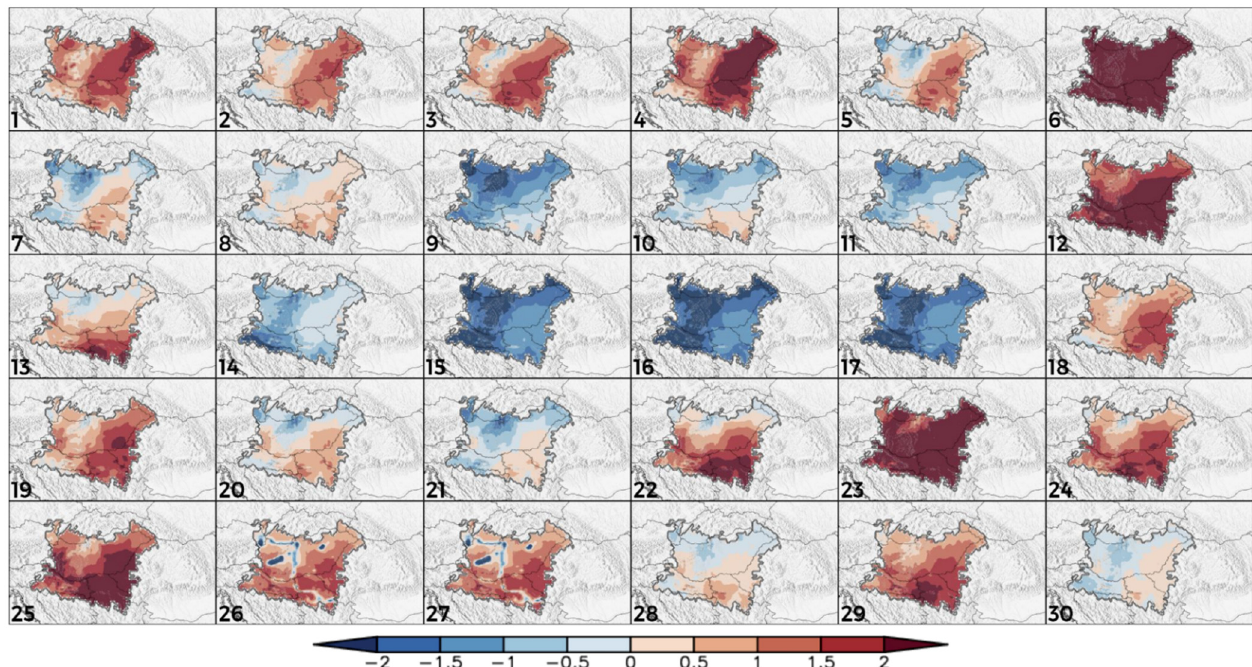
Figure 4. Mean (1971–2000) summer GCM–RCM bias of the mean temperature field compared with the E-OBS gridded dataset. Units are °C. The integration numbers follow the list from Table 1.